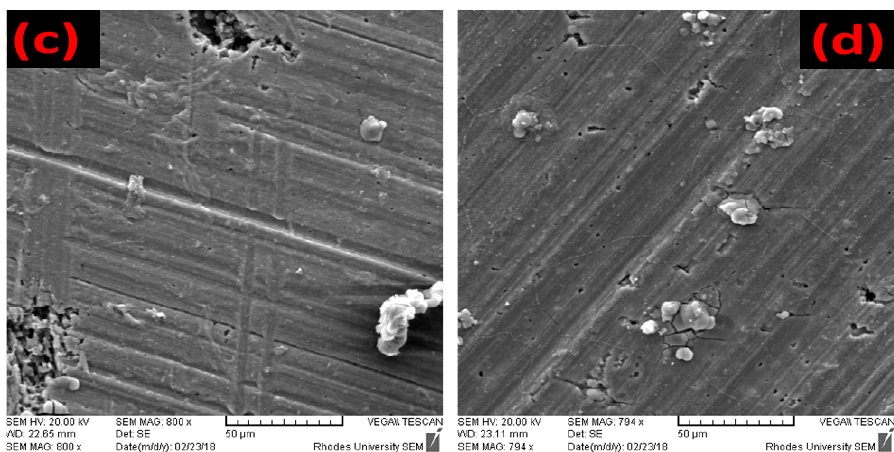
Figure 5. SEM images of ( a ) bare aluminum metal; ( b ) aluminum metal after immersion in 1.0 M HCl; ( c ) aluminum metal after immersion in 1.0 M HCl containing BTThio; and ( d ) aluminum metal after immersion in 1.0 M HCl containing ClGaBTThioPc.